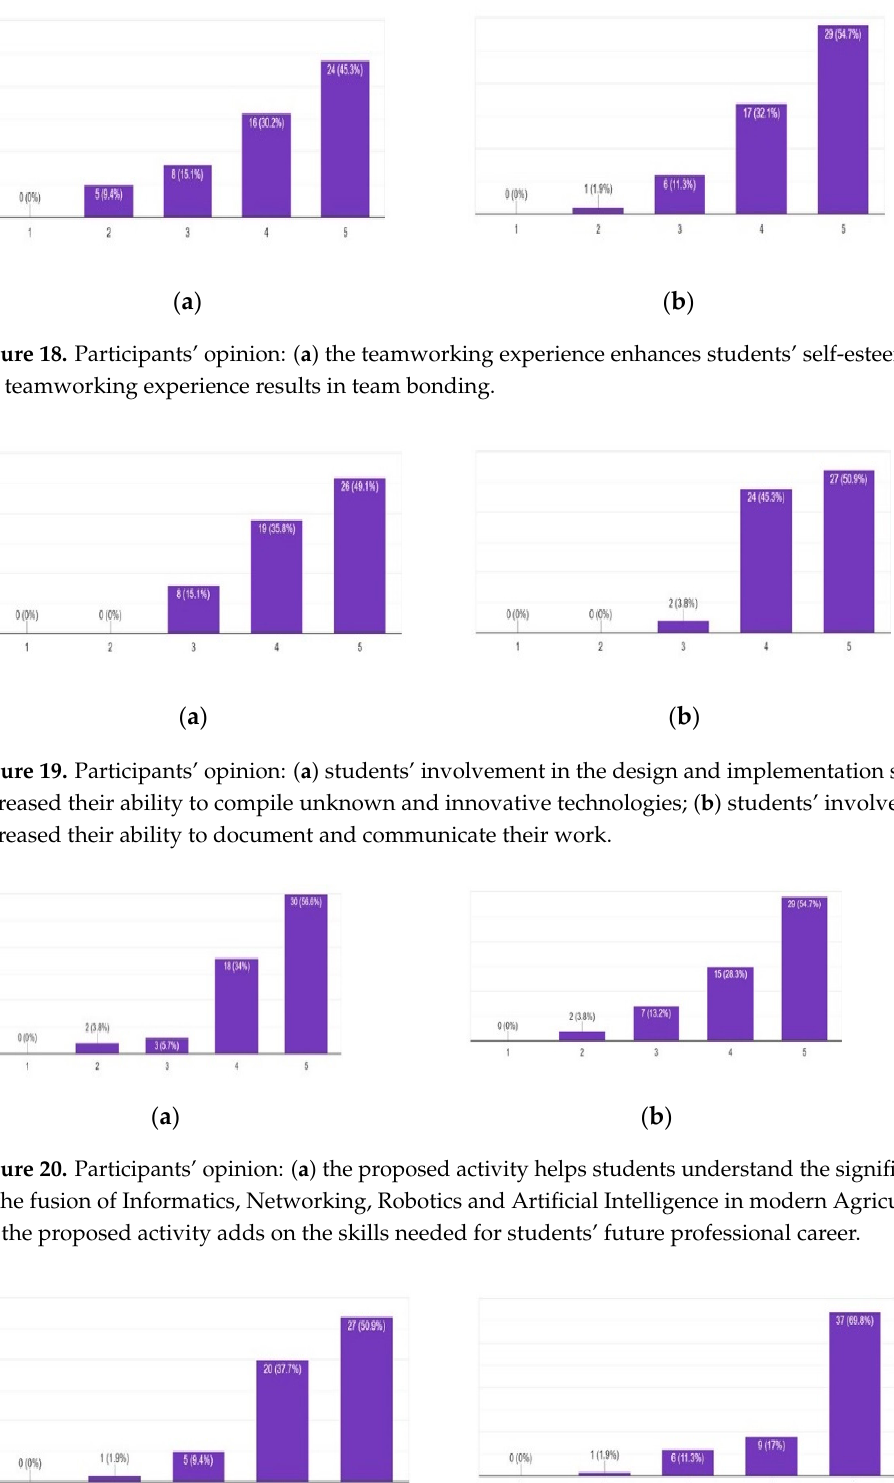
Figure 17. Participants’ opinion: ( a ) the occasional failures affect the students’ faith and cause them to lose their confidence to finish the work; ( b ) the occasional failures make students consider that their instructors are inadequate.